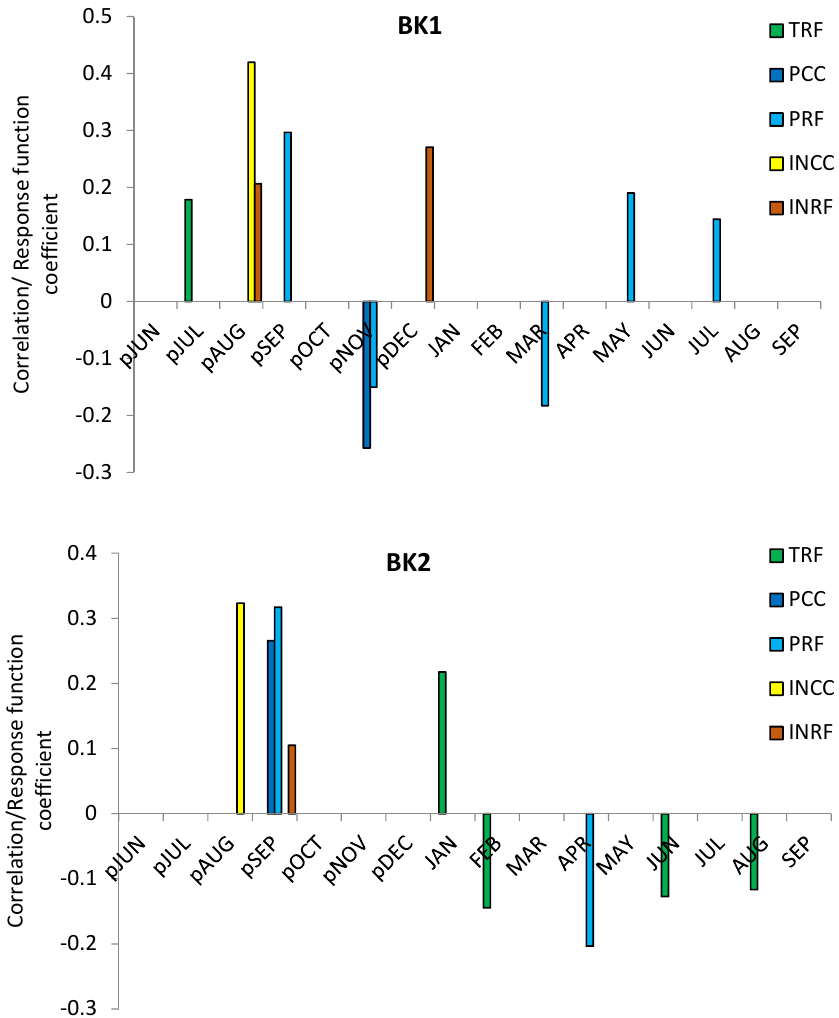
Figure 4. Significant results ( p ≤ 0.05) of correlation (CC) and response function (RF) for Pinus sylvestris chronologies from Bagno Kusowo and temperature (T), precipitation (P) and insolation (IN); p, previous year.